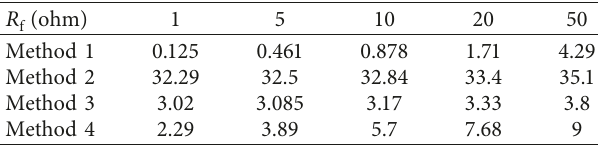
Table 3: Influence of the transient resistance on the first-moment 100km. fault location error, l real (cid:31)